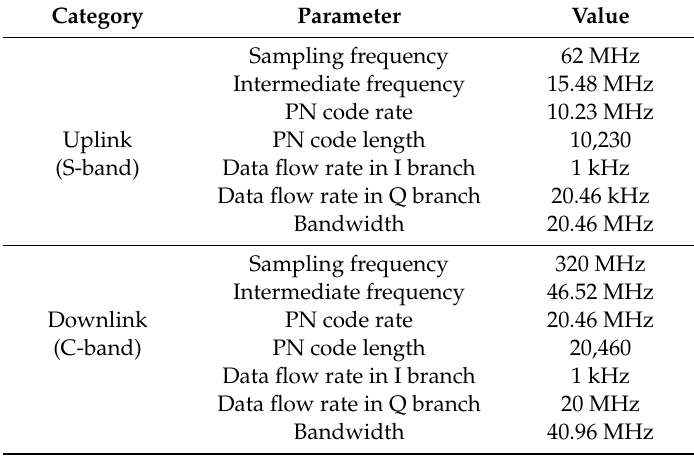
Table 2. Basic simulation parameters in simultaneous ranging and communication algorithm.